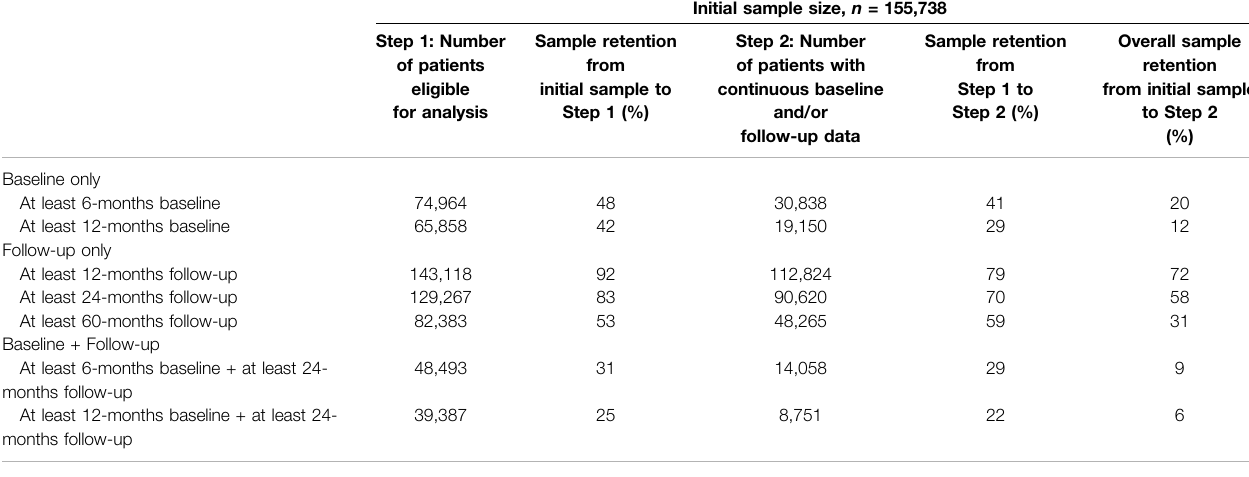
TABLE 5 | Sample attrition and data continuity among patients with type 2 diabetes mellitus in the Chang Gung Research Database.